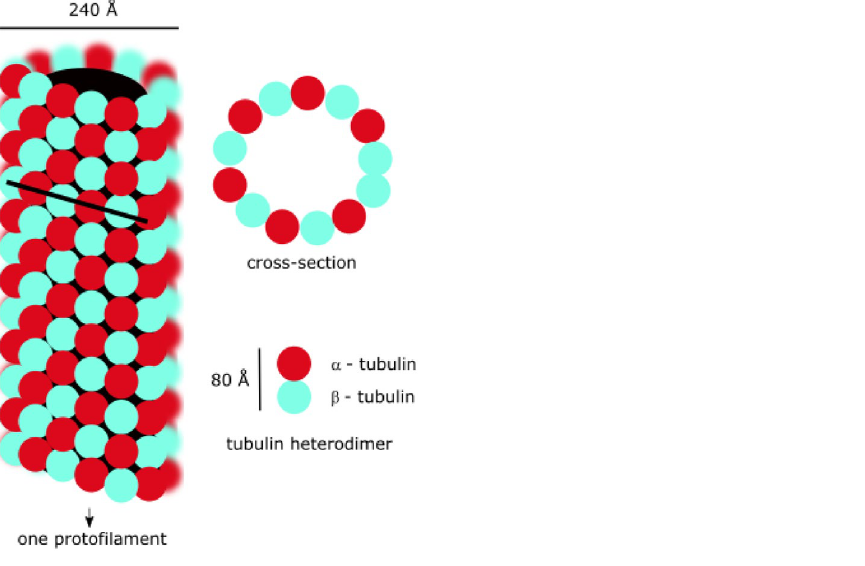
Figure 1. Structure of microtubule.